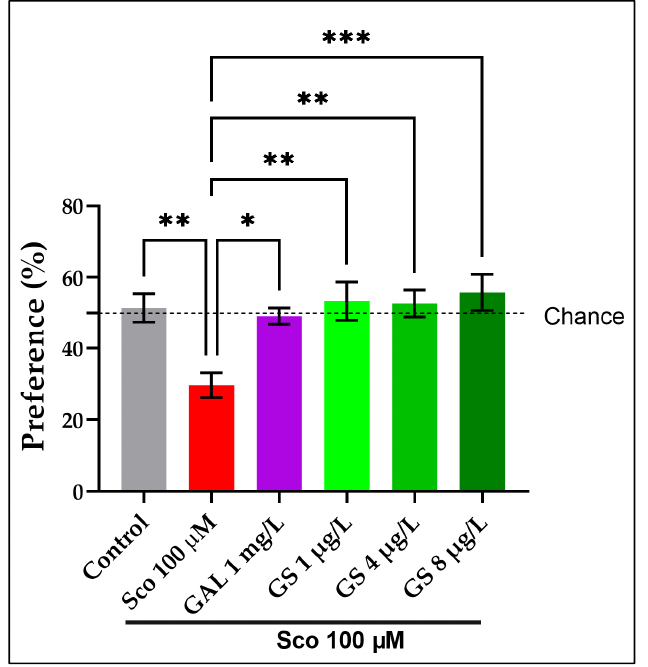
Figure 4. Guiera senegalensis hydroethanolic extract (GS: 1 μ g/L, 4 μ g/L and 8 μ g/L) improved memory in the novel object recognition (NOR) test. The figure represents the percentages of preference in different groups. Results are expressed as mean ± S.E.M. (n = 10). For Tukey’s post hoc analyses: * p < 0.01, ** p < 0.001, and *** p < 0.0001.